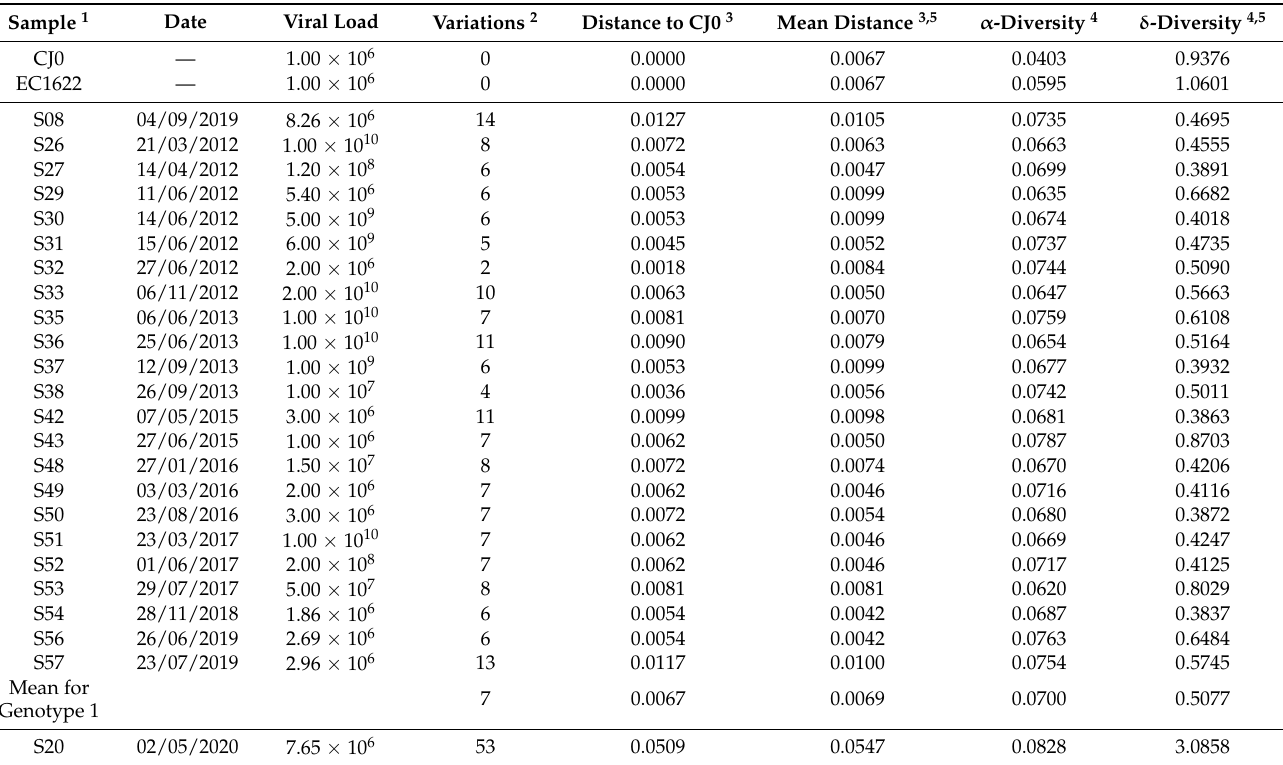
Table 1. Sample set in the study and derived distance and diversity